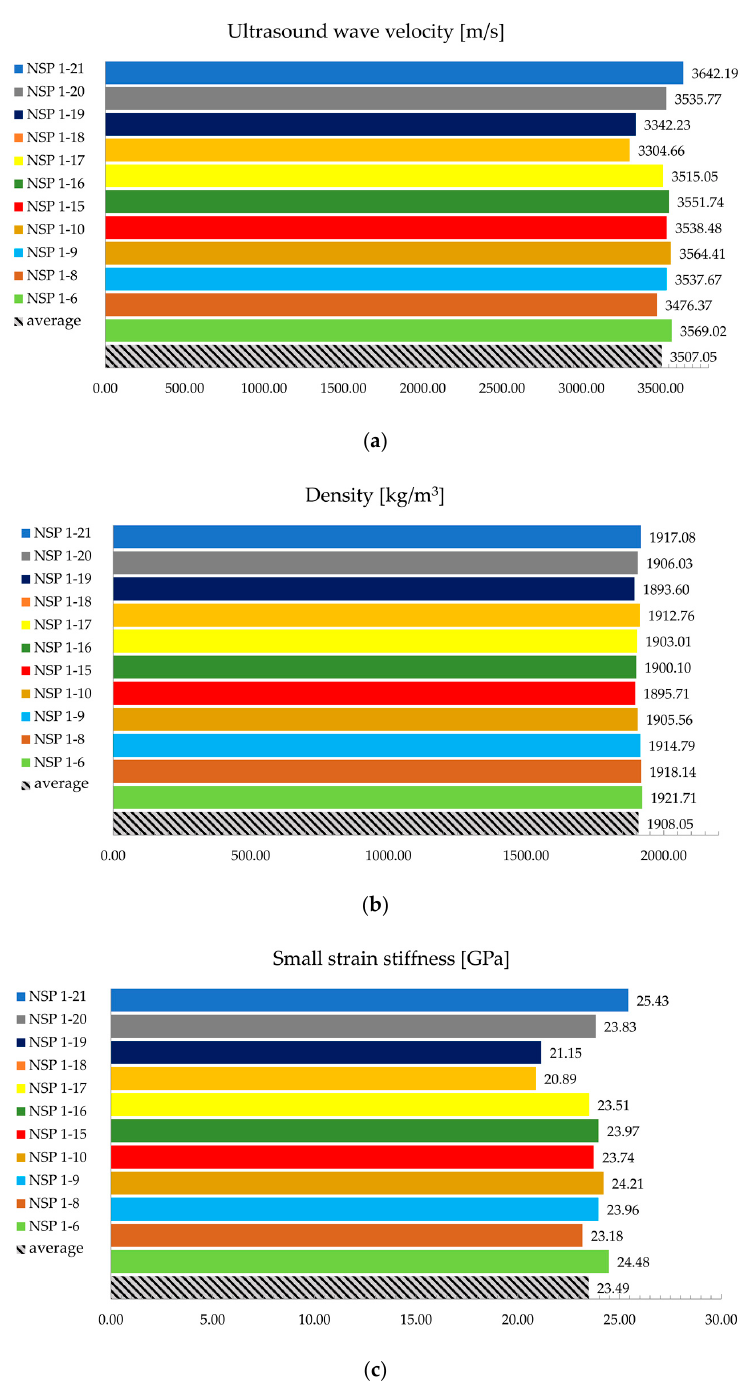
Figure 7. Laboratory test results for 30% grouted model: ( a ) ultrasound wave velocity, ( b ) density, and ( c ) small strain stiffness.